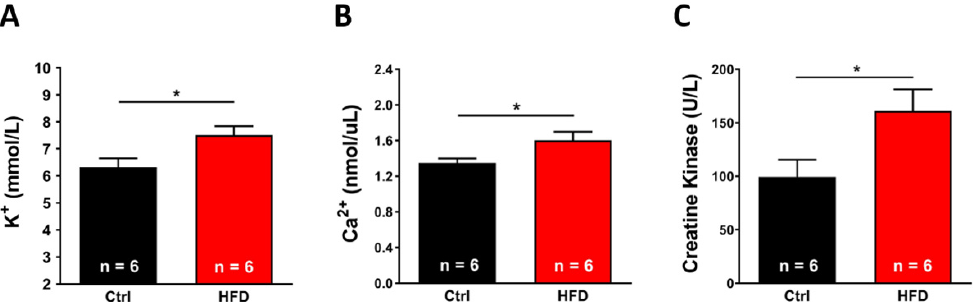
Figure 7. Blood markers of skeletal muscle damage after the heat stress protocol (41 °C for 1 h). Level of K + in plasma (mmol/L) (panel ( A )); level of Ca 2+ in plasma (nmol/L) (panel ( B )); amount of creatine-kinase (U/L) in plasma (panel ( C )). Data are shown as mean ± SEM (* p < 0.05), as evaluated by two-tailed unpaired Student’s t -test. n = number of mice tested.